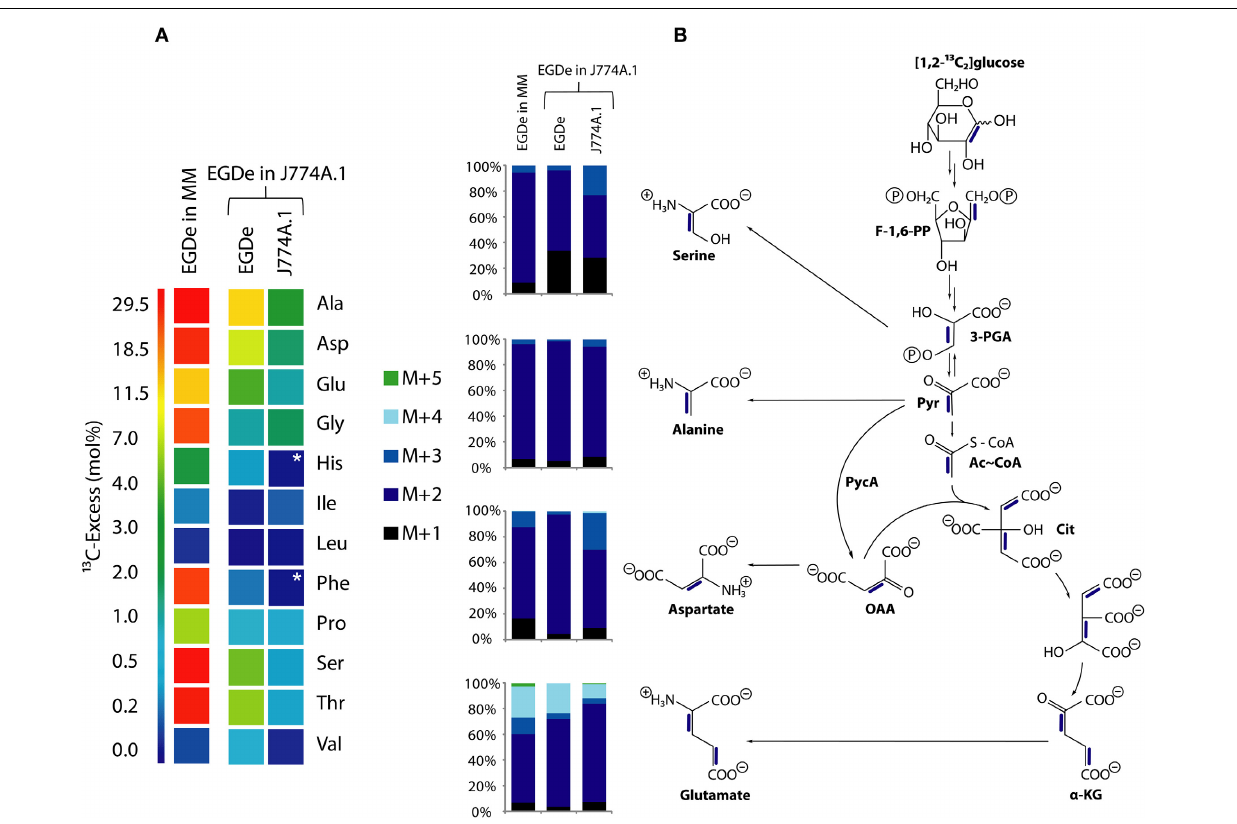
13 C-enrichments. Isotopologue profiles in listerial Ser, Ala, Asp, and Glu, respectively, from the same experiments. The colored columns indicate the relative fractions (in %) of the 13 C-isotopologues (M + 1 to M + 5) in the labeled amino acids. (B) Reaction scheme displaying the conversion of [1,2- 13 C 2 ]glucose into the detected isotopologues of Ala, Asp, and Glu. 13 C-Label is indicated by blue bars. For the numerical values, see Supplemental